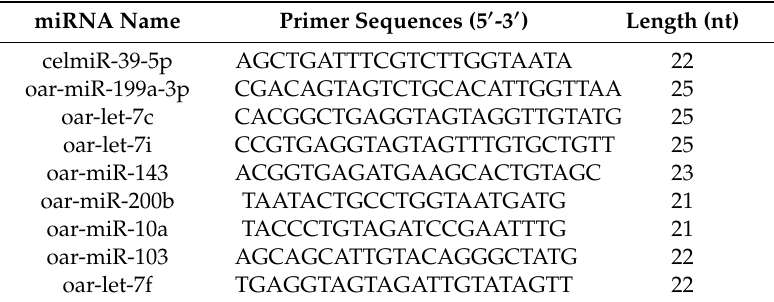
Table 1. Primers used to detect miRNA expression by